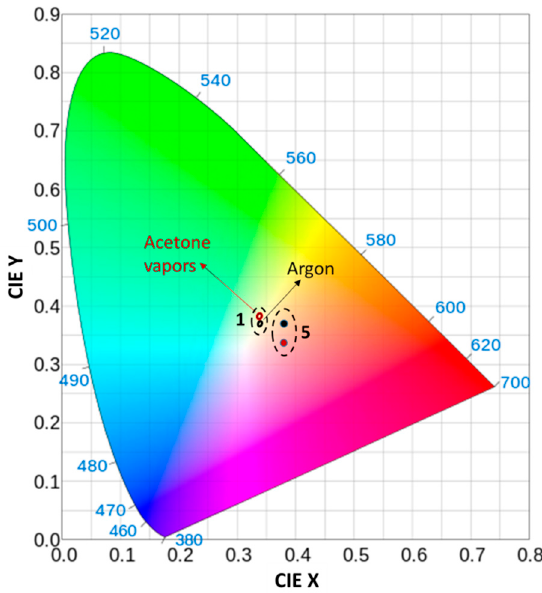
Figure 10. Calculated CIE coordinates for Nb 2 O 5 film with Na-X 120 zeolites with a concentration of 5% (label 1) and a computer-modelled five-layer Bragg stack comprising Nb 2 O 5 as a high refractive index layer and Nb 2 O 5 /Na-X 120 as a low refractive index layer (label 5) exposed to argon (black circles) and acetone vapors (red circles).